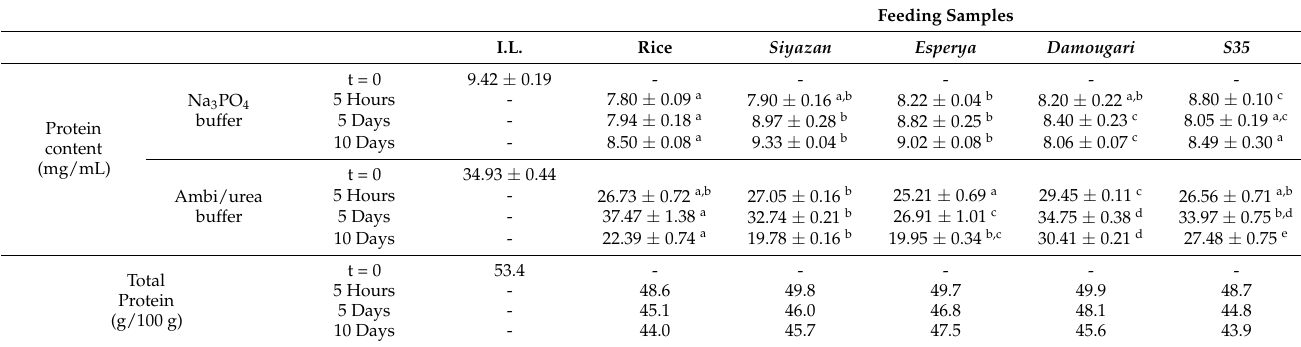
Table 2. Protein content from sodium phosphate and Ambi/urea extracts, and total protein content, determined according to the Kjeldahl method, of larvae after 5 h, 5 days and 10 days (n = 3). Feeding Samples I.L. Rice Siyazan Esperya Damougari S35